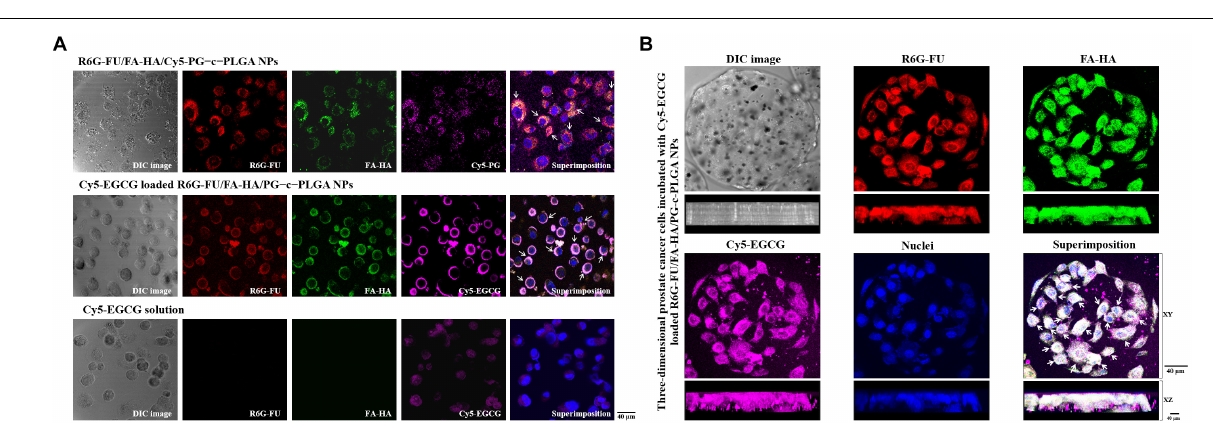
The three-dimensional PC3 cells were incubated with fluorescent EGCG-loaded NPs. CLSM analyses showed the superimposition of the images produced by Cy5-EGCG-loaded